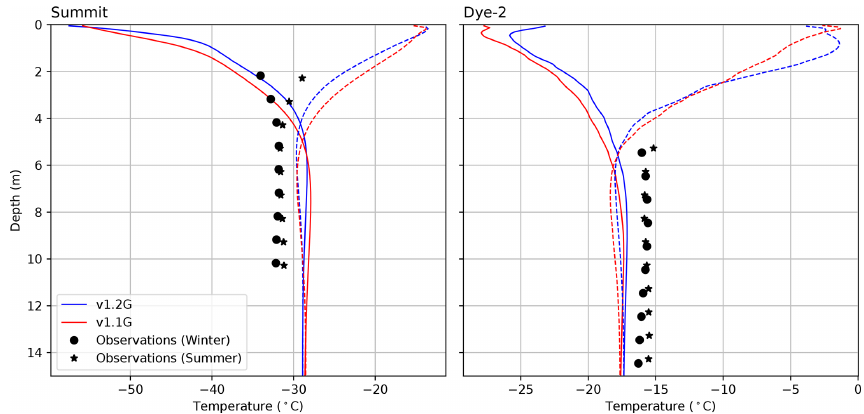
Figure 8. Comparison between observed temperature profiles vs. modelled profiles by v1.1G and v1.2G in summer (dashed lines) and winter (solid lines) at Summit in winter (9 March 2002) and summer (6 August 2002) and Dye-2 in the summer (10 August 2007) and winter (13 March 2007). The blue lines indicate the uncertainty in the v1.2G